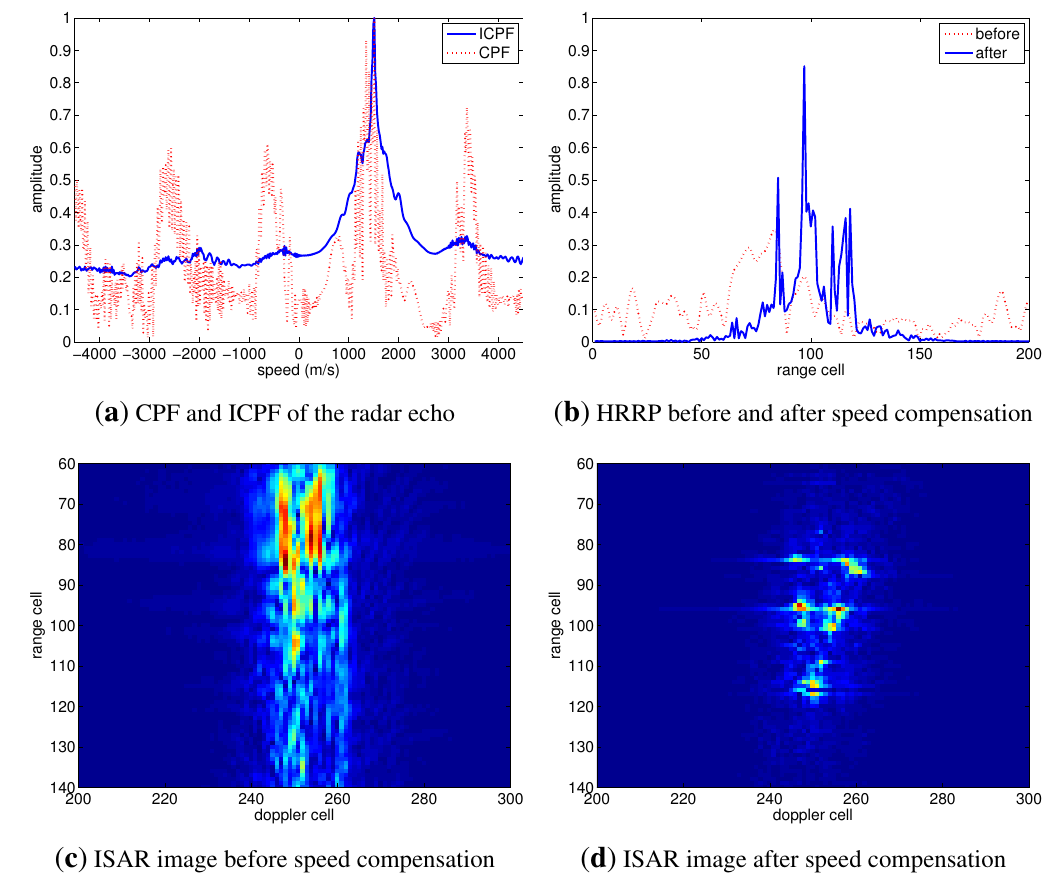
Figure 5. Speed compensation results of the simulated radar target with a speed of 1500 m/s.